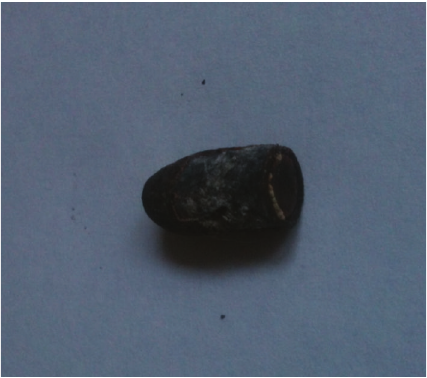
Figure 3: The bullet after its